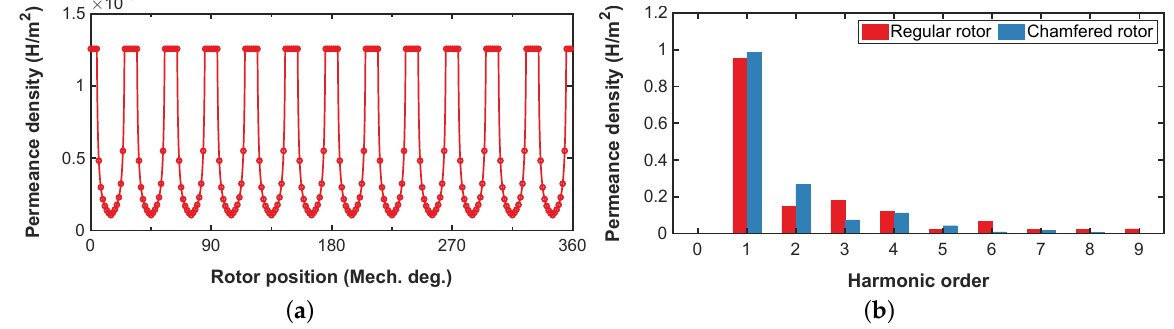
Figure 4. Stator permeance in regular VPM structure with infinite permeability. ( a ) Permeance plot; ( b ) Permeance spectrum.